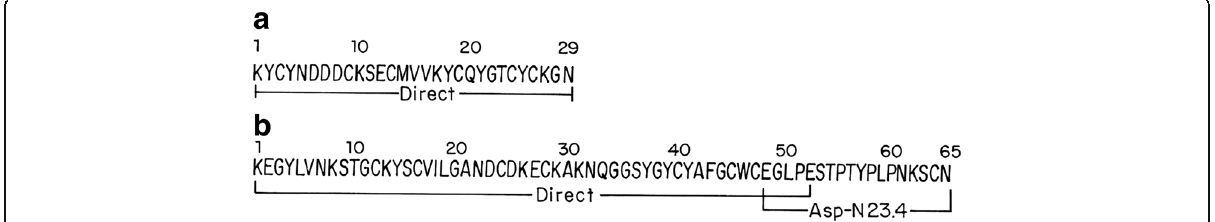
Fig. 3 Primary structure of purified peptides. ( a ) Peptide with molecular weight 3421.84 Da, containing 29 amino acids. Captioned “ Direct ” means sequence obtained directly by automatic Edman degradation. ( b ) Peptide of 7051.53 Da containing 65 amino acids and sequenced directly by Edman degradation, and completed by sequencing the peptide “ Asp N 23.4 ” obtained after enzymatic digestion of a reduced and alkylated sample